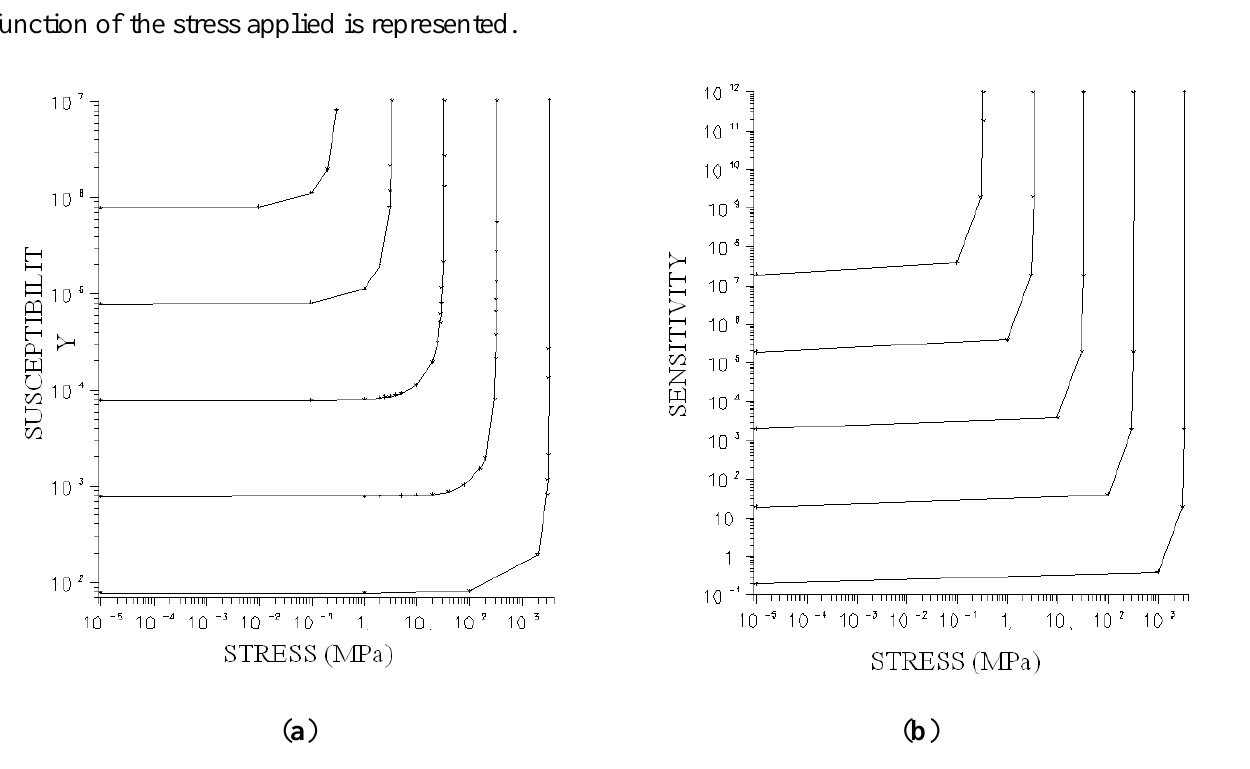
Figure 1. Susceptibility ( a ) and sensitivity ( b ) variation with applied